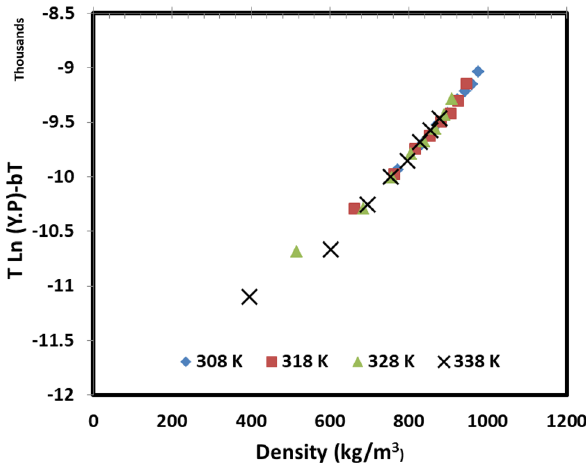
Figure 4. Extrapolative analysis based on MST